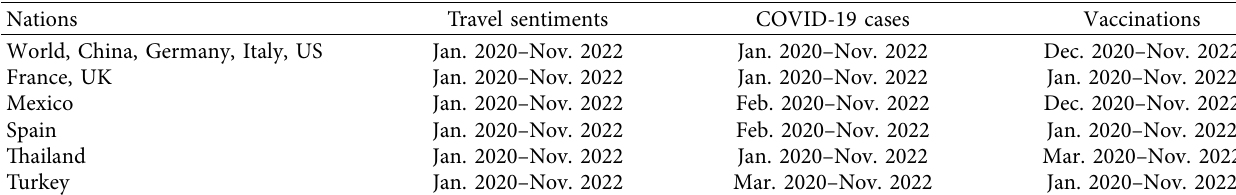
Table 1: Te length of the